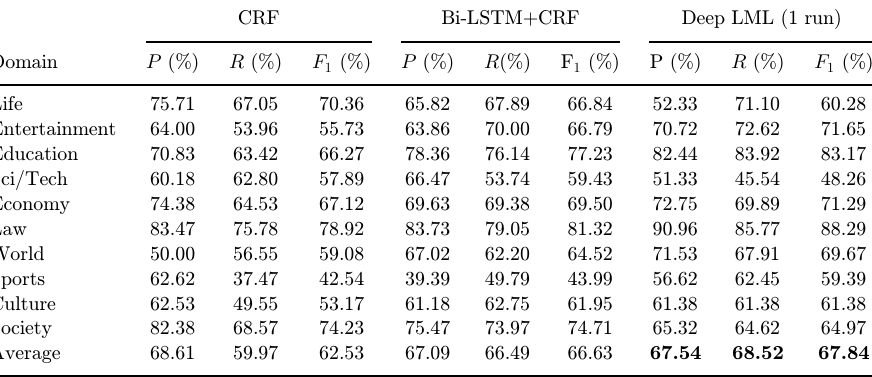
Table 5. Cross-domain results (1 run). CRF Bi-LSTM+CRF Deep LML (1